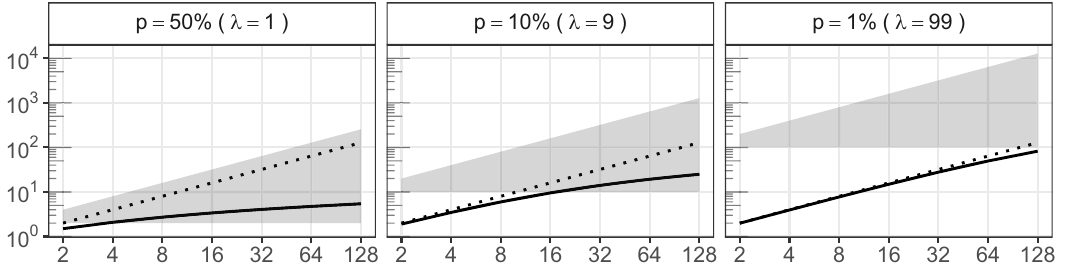
Figure A1: The expected number of transitions in the MDCM ( solid line ) and expected number of transitions in the LFM ( gray area ) for the Exponential family; the dotted line marks the